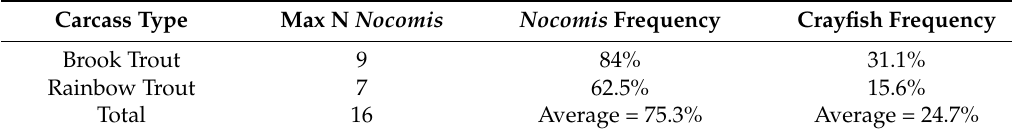
Table 1. Summary of scavenging events observed on brook and rainbow trout showing the maximum number of scavenging fish observed at any one time (Max N); frequency of video events with Nocomis micropogon (river chub) scavenging; and frequency of videos with crayfish observed scavenging. Percentages calculated from 77 total video events (45 Brook and 32 Rainbow trout) across 5